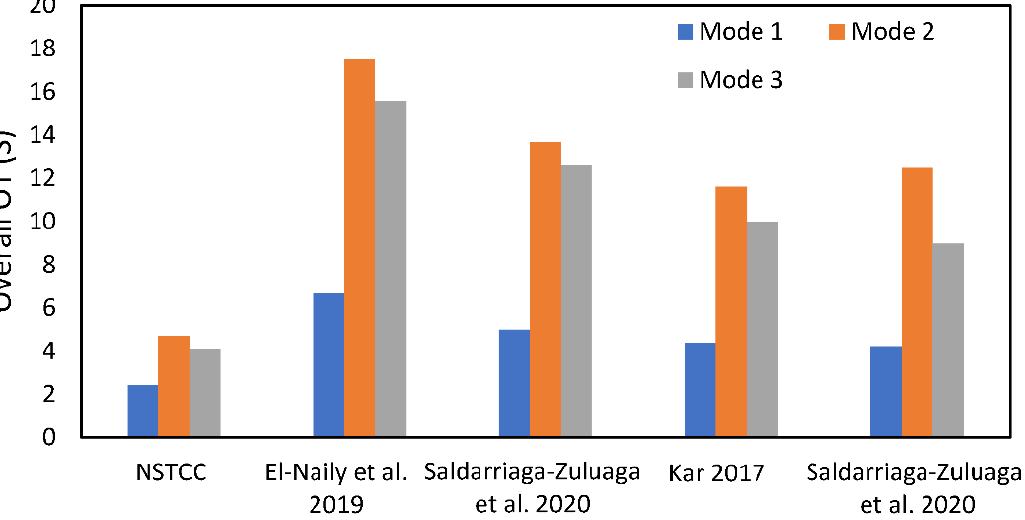
Figure 11. The overall OT in Modes 1, 2, and 3 for the radial IEC MG by different approaches from the literature (Saldarriaga-Zuluaga et al. 2020 [29], El-Naily et al. 2019 [36], Kar 2017 [51], Saldarriaga-Zuluaga et al. 2020 [52]).